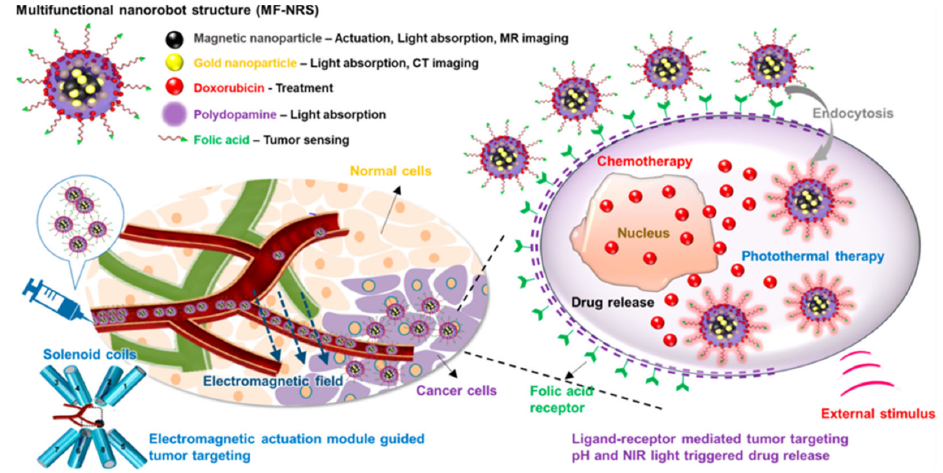
Figure 12. Multifunctional magnetic nanorobot structure diagram for cancer therapy [238]. Reprinted from Ref. [238]. Copyright 2019 ACS.